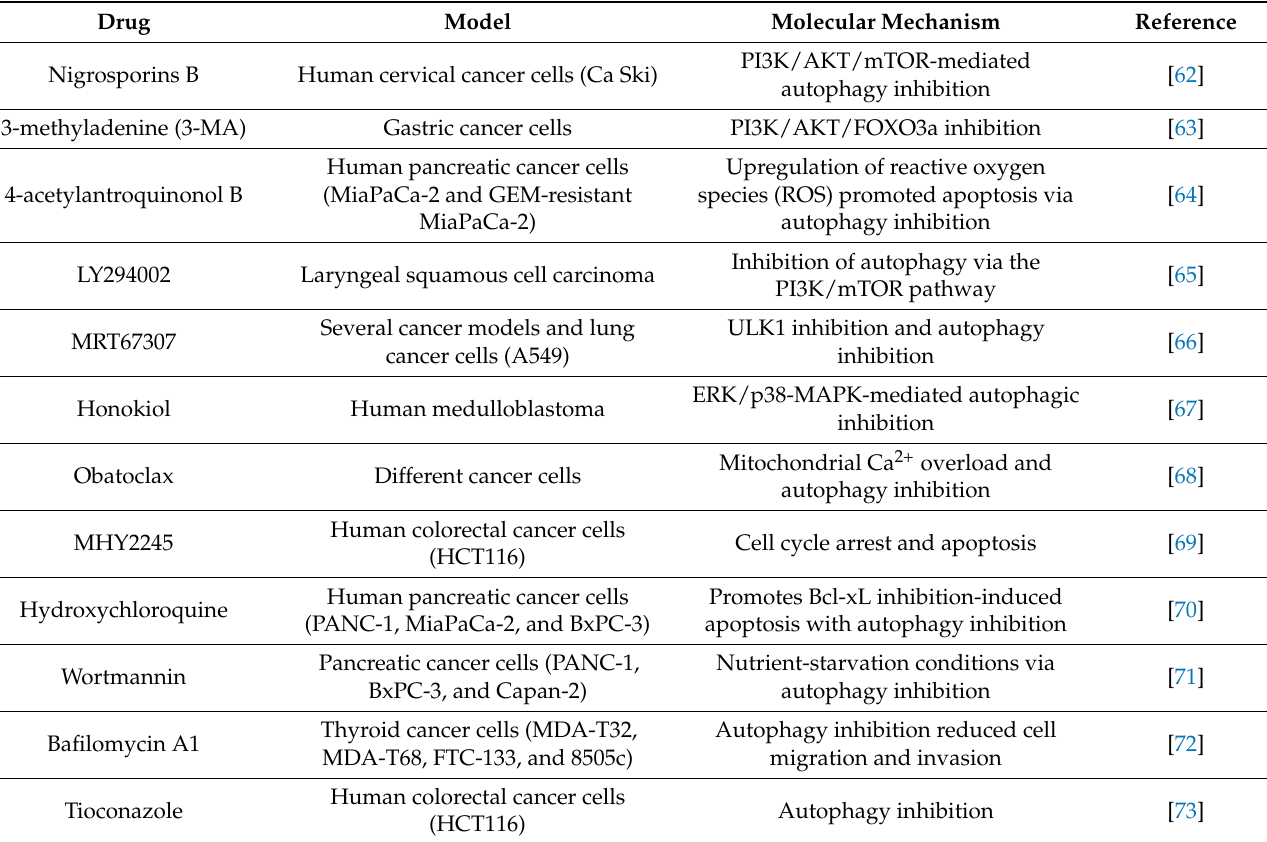
Table 2. Recently used autophagy inhibitors and their mechanisms of action in different